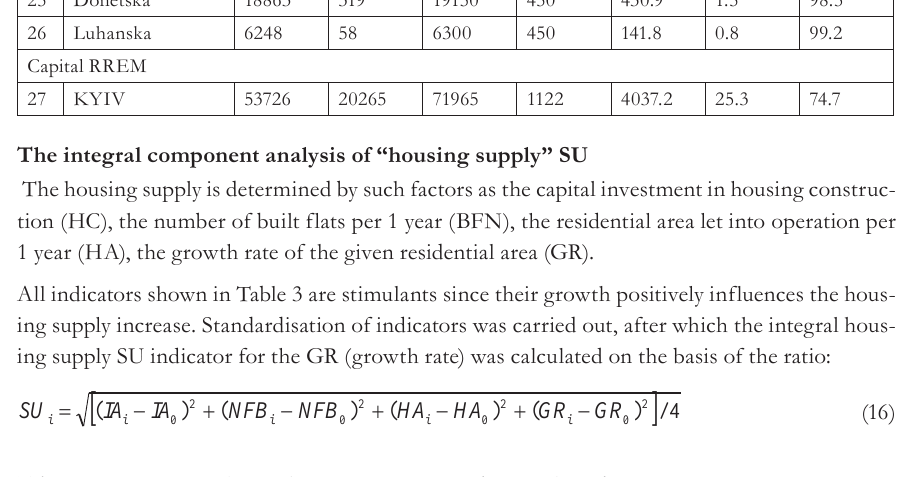
Tab. 3 – Housing supply in Ukraine regions according to their division into RREM, on January 1, 2017, (excluding the temporarily occupied territory of the Autonomous Rep. of Crimea, the city of Sevastopol and parts of the zone of anti-terrorist operation in Donetska, Luhanska re- gions). Source: Ministry of Justice of Ukraine (2019), State Statistics Service of Ukraine (2019)